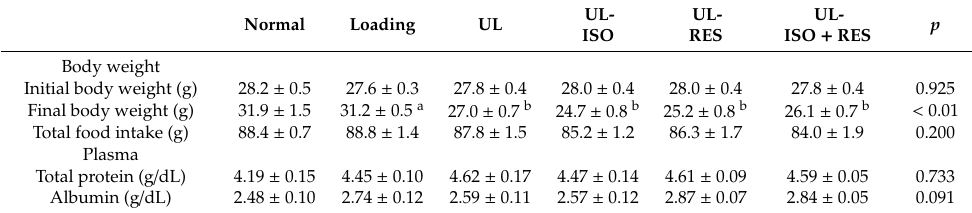
statistical analyses. Differences among the groups were assessed by Tukey’s post hoc test. If variances were not equivalent, the data analysed Kruskal–Wallis ANOVA, and followed by a Steel-Dwass test. Differences were considered significant when P < 0.05. a, b Mean values with unlike letters were significantly different.